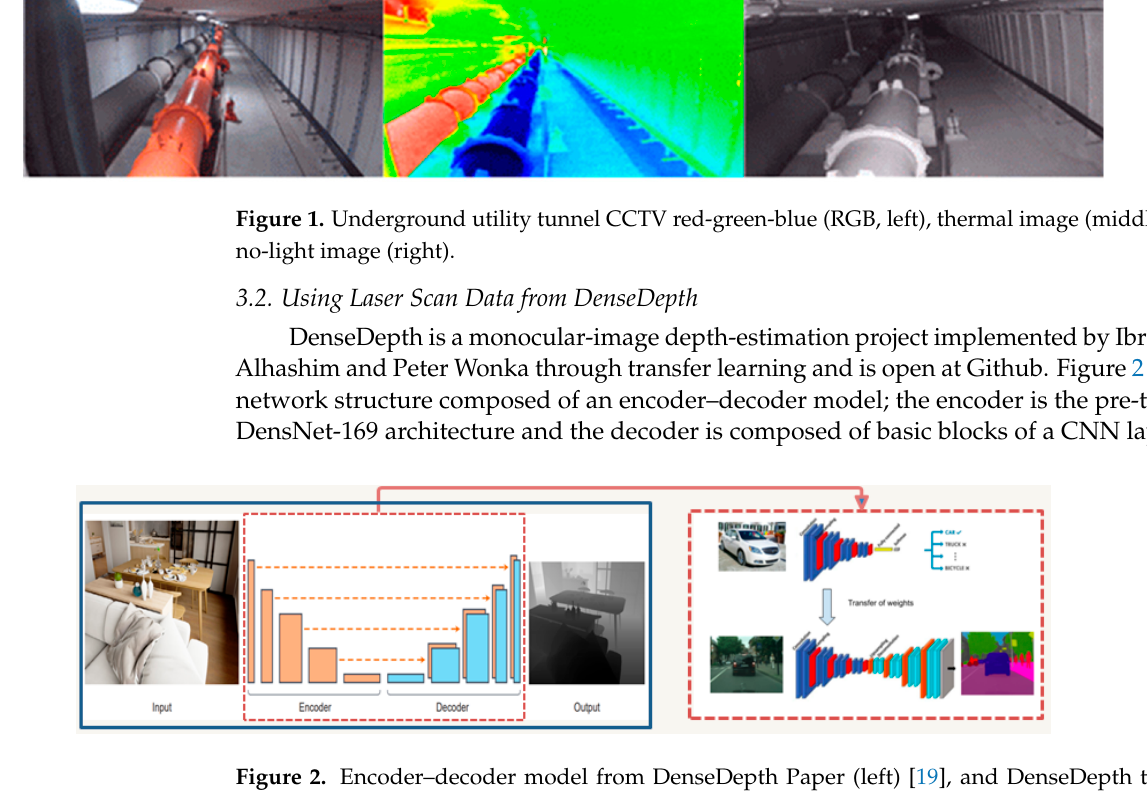
Figure 2. Encoder–decoder model from DenseDepth Paper (left) [19], and DenseDepth transfer learning network structure (right)